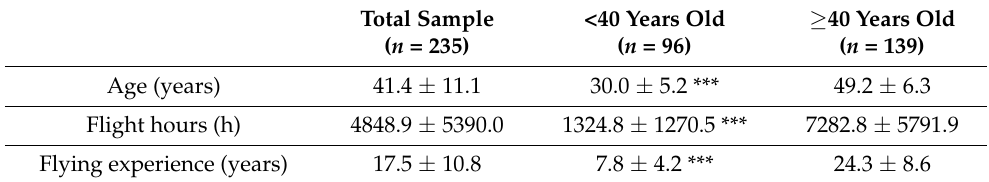
Table 1. Description of the total sample and sorted by age groups.